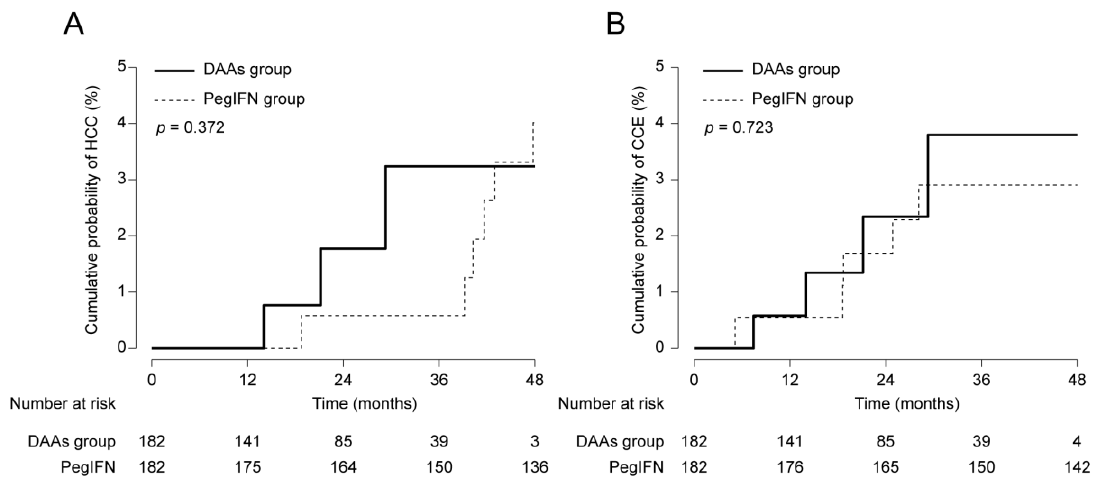
Figure 2. Cumulative probabilities of HCC ( A ) and CCE ( B ) development between the DAAs and PegIFN groups after propensity score (PS) matching analysis.